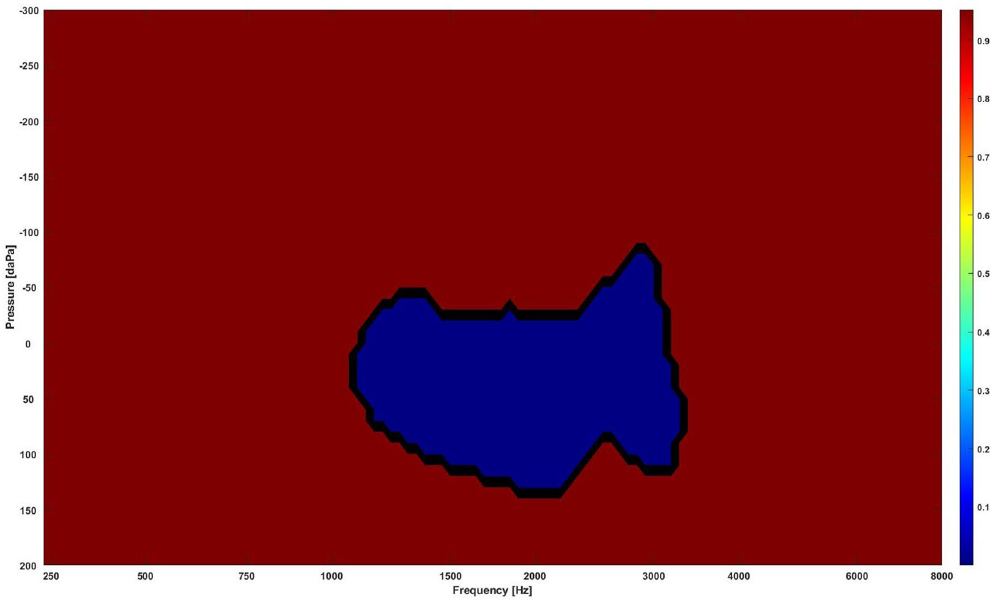
Figure 5. The most significantly different region (blue) in the WAI data. The blue region is the region with the lowest p -values that contains 10% of the data ( 51 ∗ 107 ∗ 10% = 546